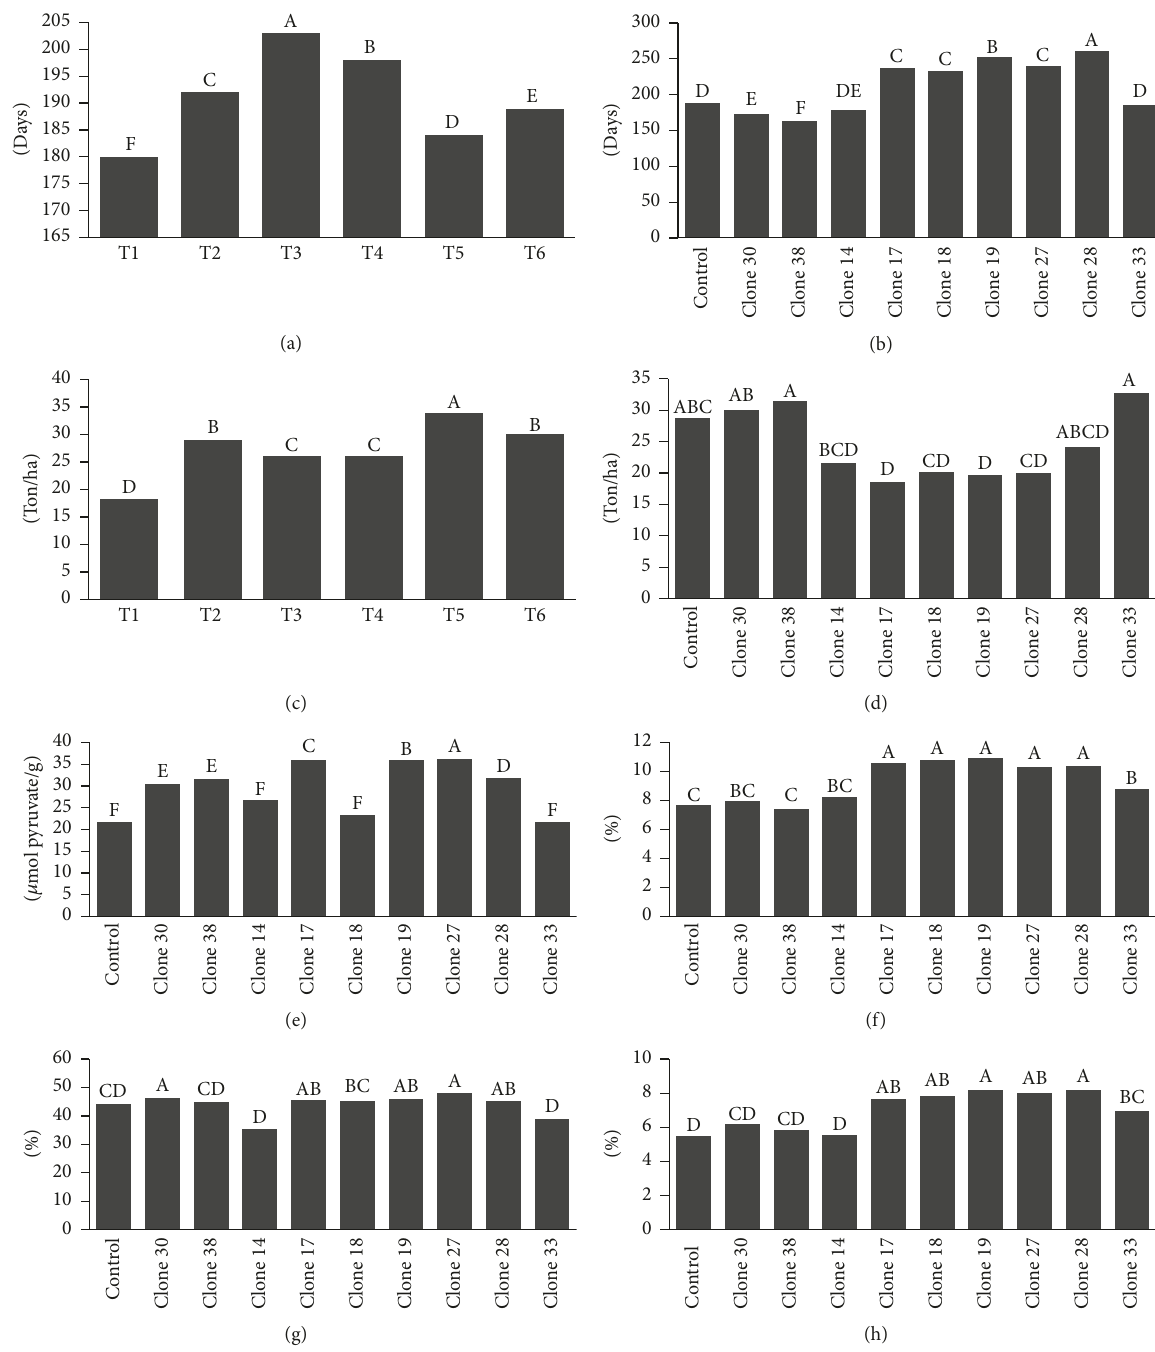
Figure 2: Earliness, yield, and processing traits were evaluated for ten genotypes of bunching onion. (a) Days to harvest (DTH) by trials; (b) DTH by genotypes; (c) yield by trials; (d) yield by genotypes; (e) pyruvate concentration; (f) dry matter content; (g) paste production (final paste weight/initial weight); (h) powder production (final powder weight/initial